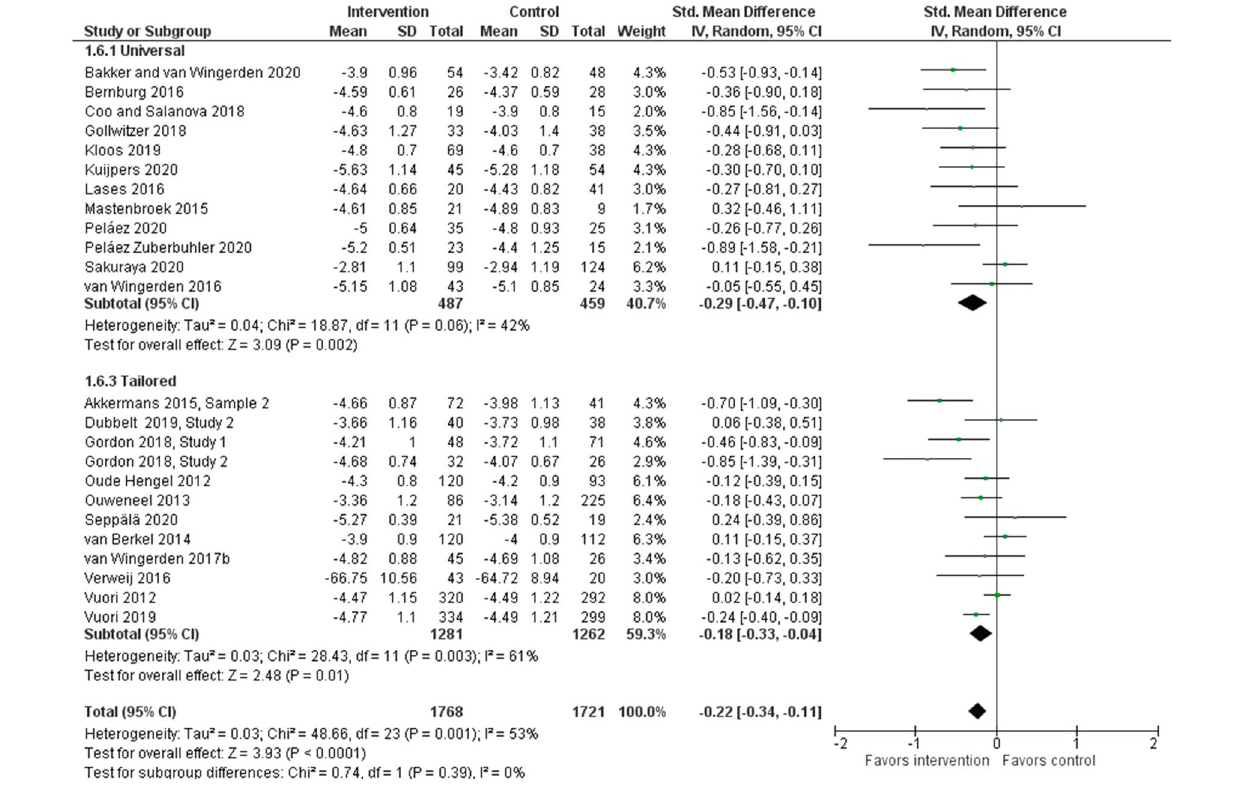
FIGURE 5 | Effect of bottom-up, resource-developing interventions versus no-intervention controls on work engagement according to intervention